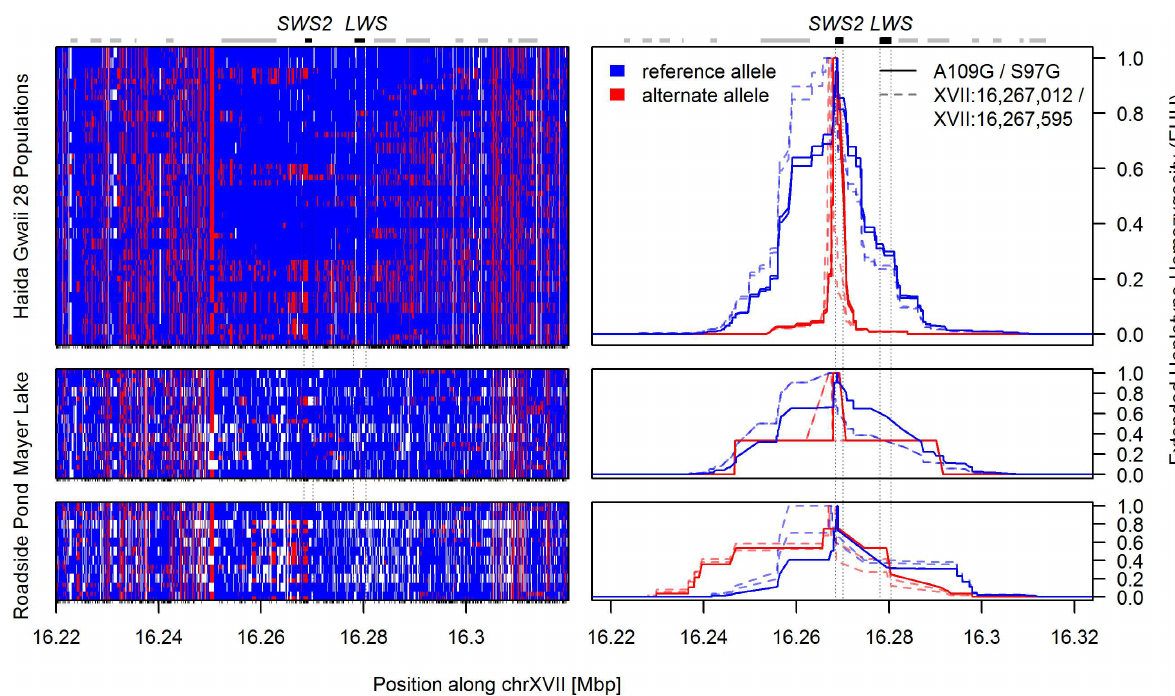
Fig 2. Haplotype structure and extended haplotype homozygosity around SWS2 and LWS . Left panels show phasedhaplotypes, right panels the decay of haplotypehomozygosity aroundselectedSNPs, each for the adaptiveradiation(upper panels)and the selection experiment dataset (middle and lower panels). The selective sweep signature seen in Fig 1 is caused by a long run of reference alleles (blue, upper left panel). This led to an extendedhaplotypehomozygosity (EHH) signalat SNPs in the top H12-window(dashedlines in top right panel): haplotypehomozygositydecays slowly aroundthe reference allele(blue) for these SNPs, but rapidly aroundtheir alternate alleles(red). Decay is similar for SWS2 key amino acid substitutionsA109G and S97G (full lines). In the selection experiment (middle/ lower panels), the same EHH decay is found for the reference haplotype, but the alternate haplotypeshows reduceddecay, in particular in the transplant populationRoadsidePond. Rows in the left panel show haplotypes with imputedSNPs and monomorphic sites with missing data (white). Columns represent SNPs with color code relative to the threespine stickleback reference genome,a freshwater stickleback female [6]. Gene positionsare indicatedwith boxes above the figure. The haplotypematrix and EHH values can be found in S1